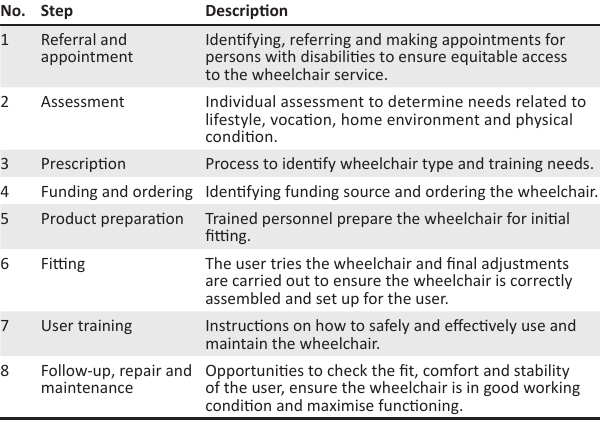
TABLE 1: Service delivery